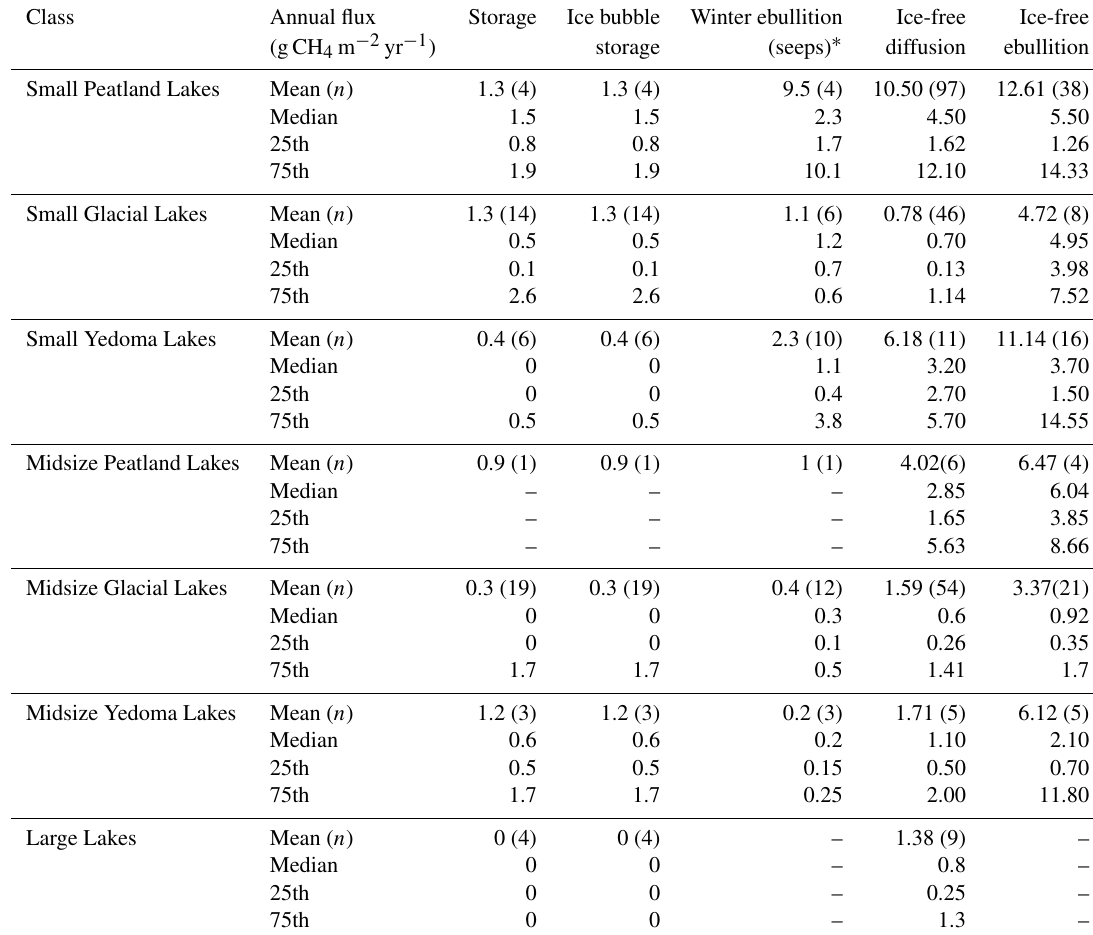
Table 5. Winter fluxes, including storage, ice bubble storage (IBS), and winter ebullition for each class type. Annual estimates of ice-free diffusion and ebullition are included for comparison. ∗ Winter ebullition from constant seeps not included in sum of winter and ice-out